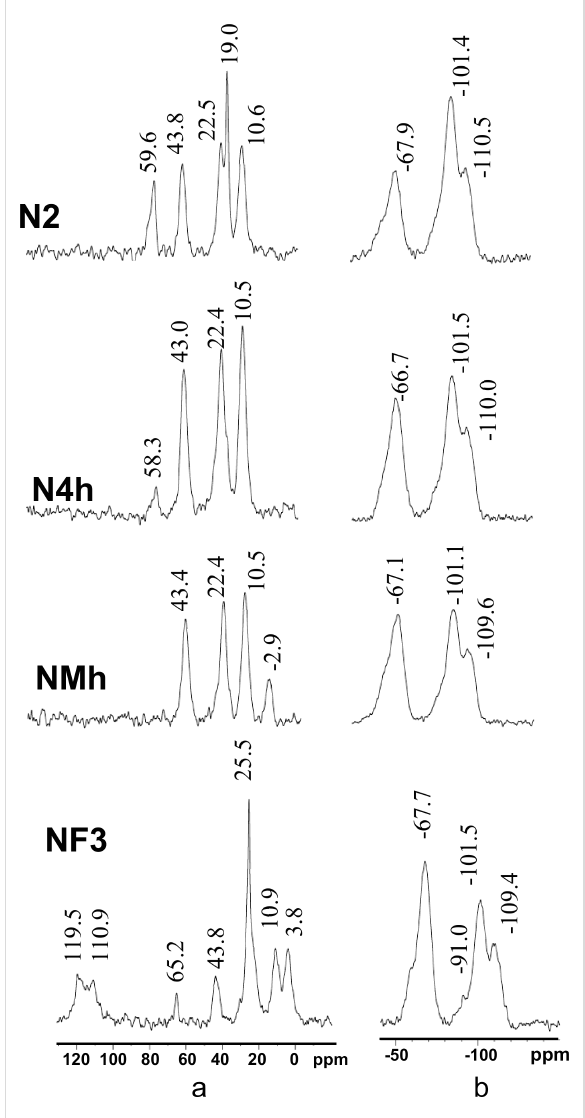
Figure 3: 13 C (a) and 29 Si (b) CP/MAS NMR spectra of the synthe- sized